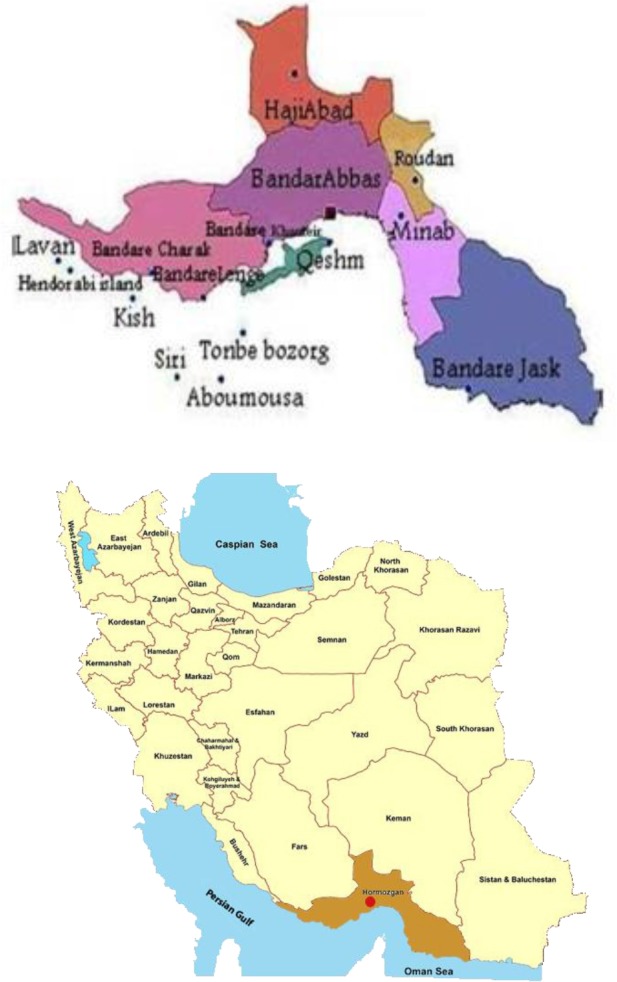
Location of BandarAbbas in the map of Iran